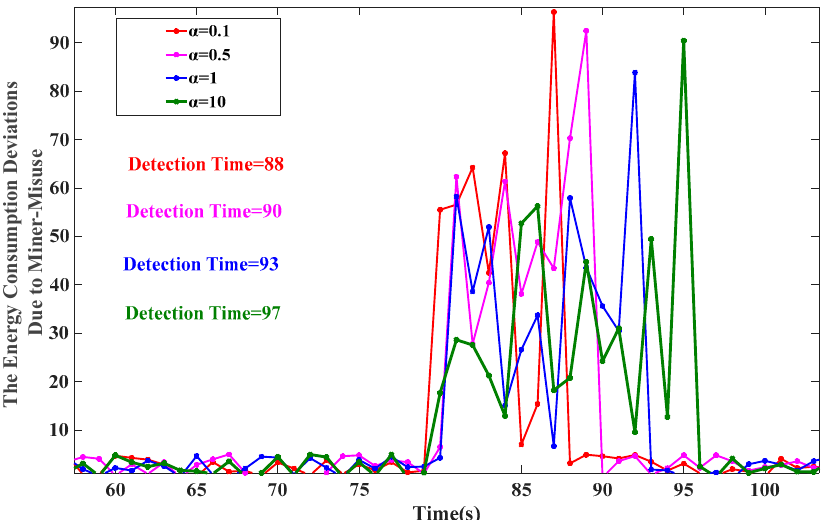
Figure 8. Illustration of the energy consumption deviations for different 𝛼.